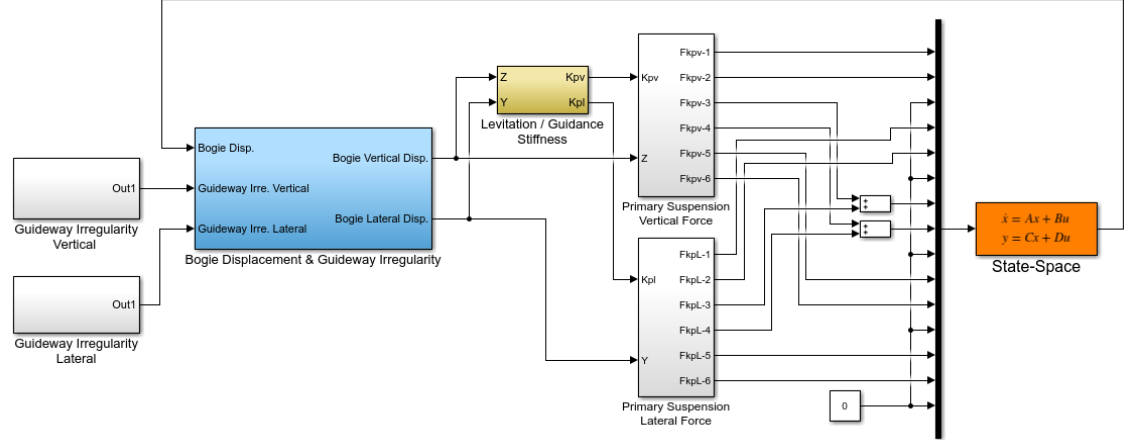
Figure 17. Modeling of capsule vehicle with Simulink S/W.